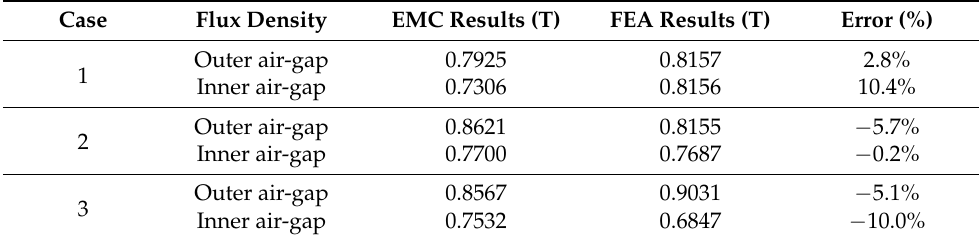
Figure 6. Magnetostatic field analysis of case 1 of the CMGT by FEA: ( a ) flux density distribution, ( b ) outer air-gap waveform, ( c ) inner air-gap waveform. Table 5. Comparison of the air-gap flux density for EMC and FEA